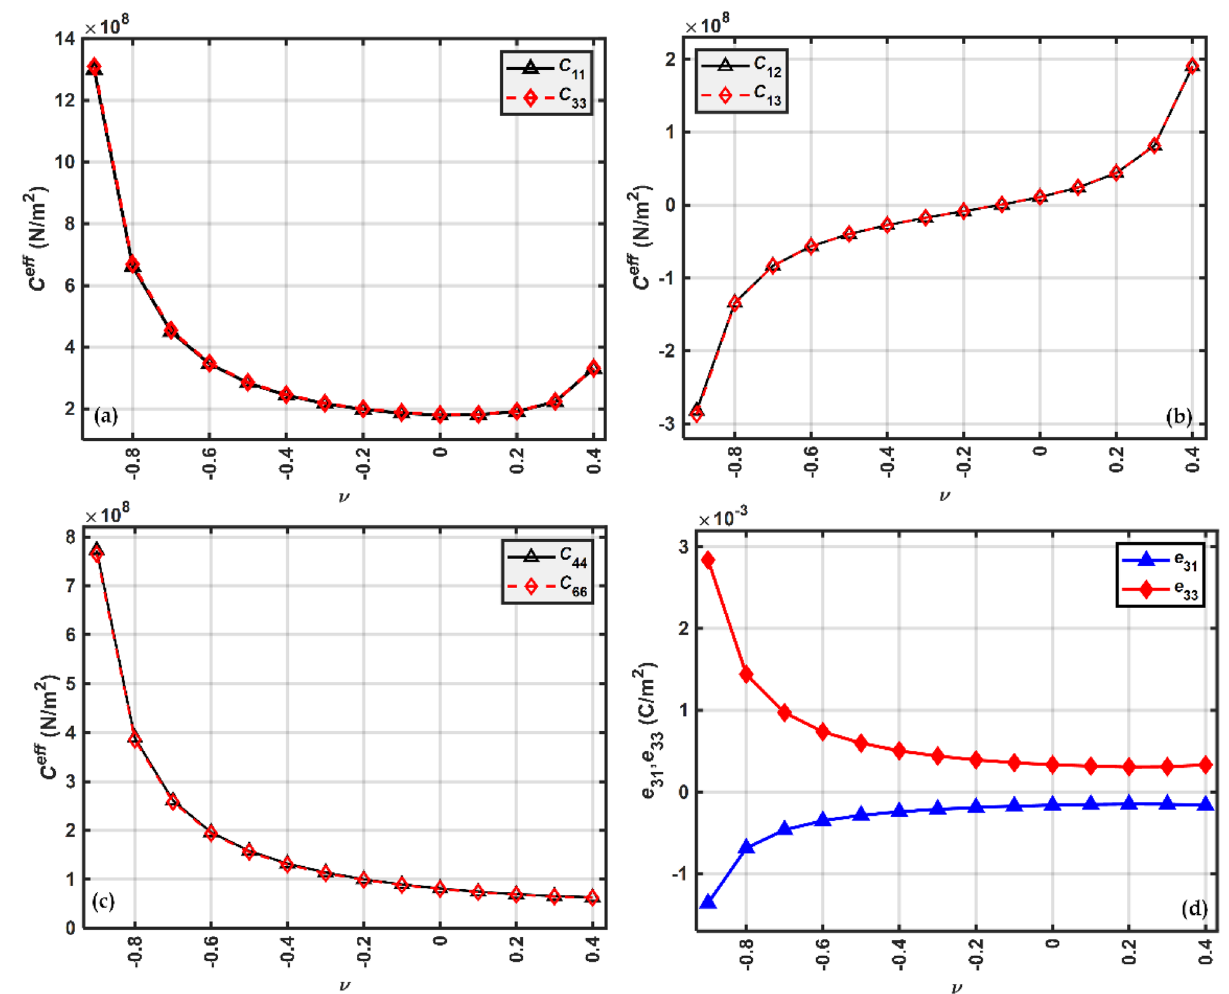
Figure 14. Effective stiffness and piezoelectric properties variation with Poisson’s ratios ( a ) C 11 , C 22 ( b ) C 12 , C 13